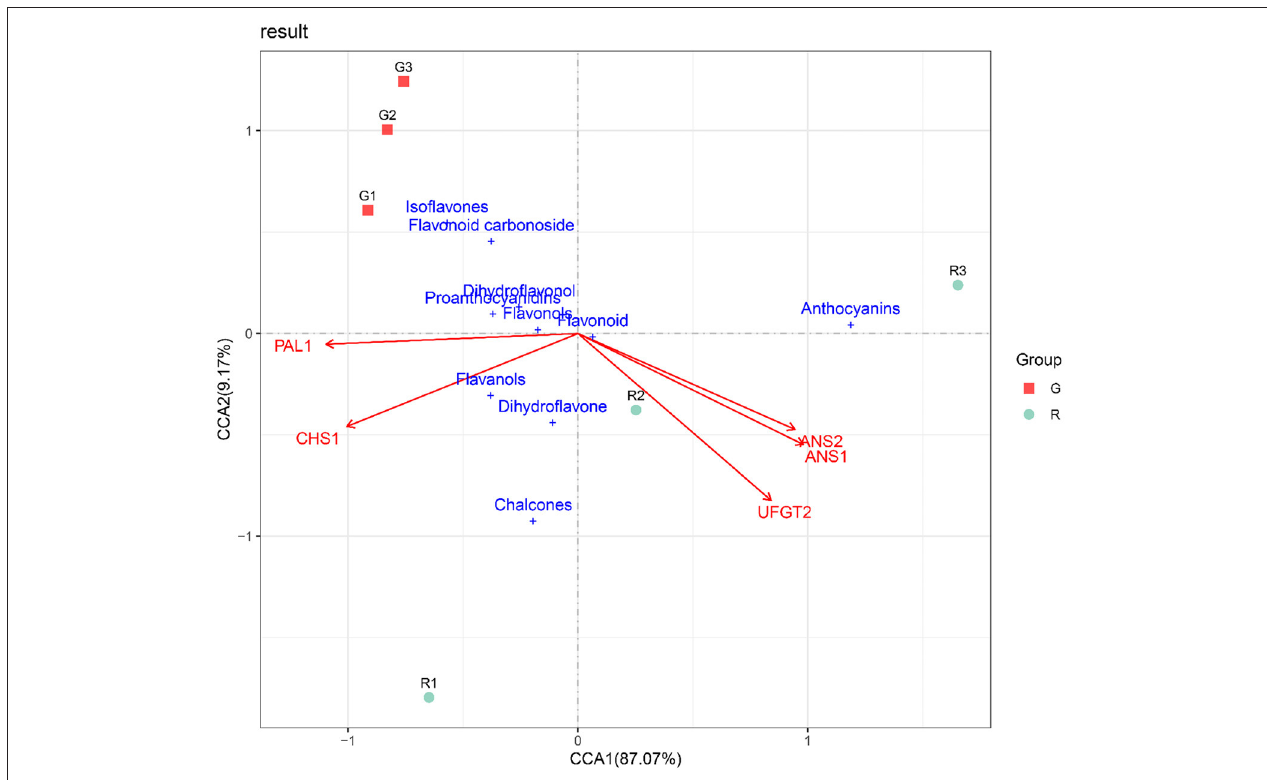
FIGURE 6 | RDA analysis of flavonoid synthesis-related genes and flavonoid content in different growth periods of red and green prickly ash